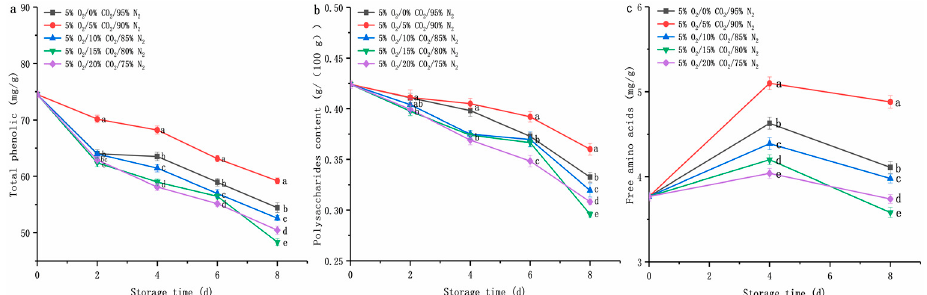
Figure 5. Effect of CO 2 concentration (%) with 5% O 2 on total phenolic ( a ), polysaccharides content ( b ), and free amino acids ( c ) of fresh-cut Dictyophora rubrovolvata . Differences at p < 0.05 are indicated by different letters and data are expressed as the mean ± SD.